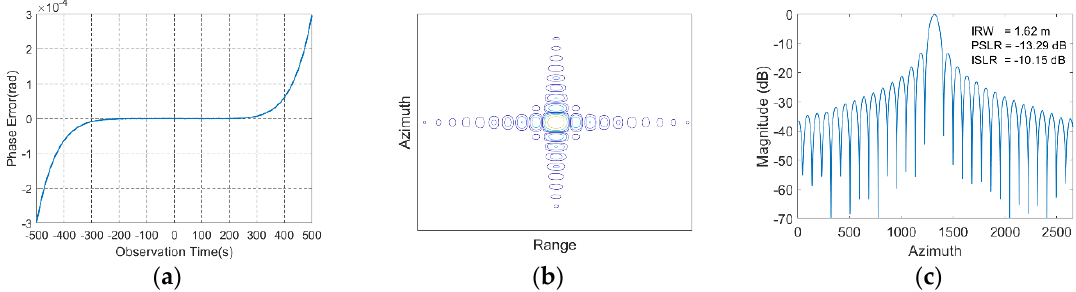
Figure 17. The fitting error and focusing result of sixth-order expansion at 45° of true anomaly. ( a ) Fitting error; ( b ) 2-D contour; and ( c ) azimuth profile.